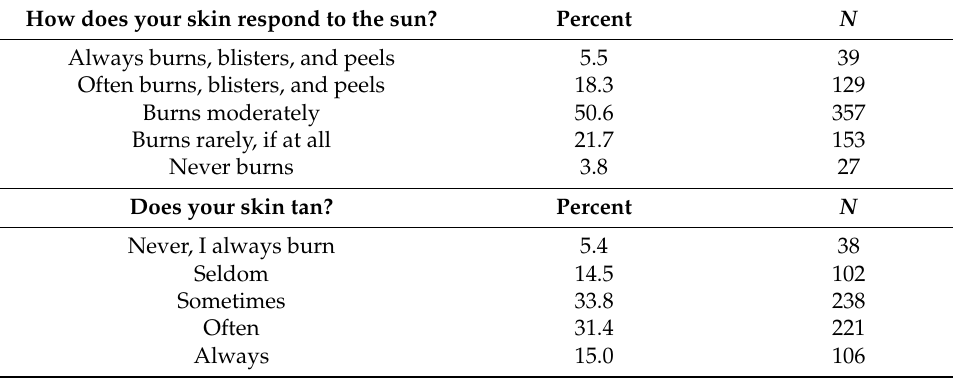
Table 1. Participants’ skin type assessment ( n =